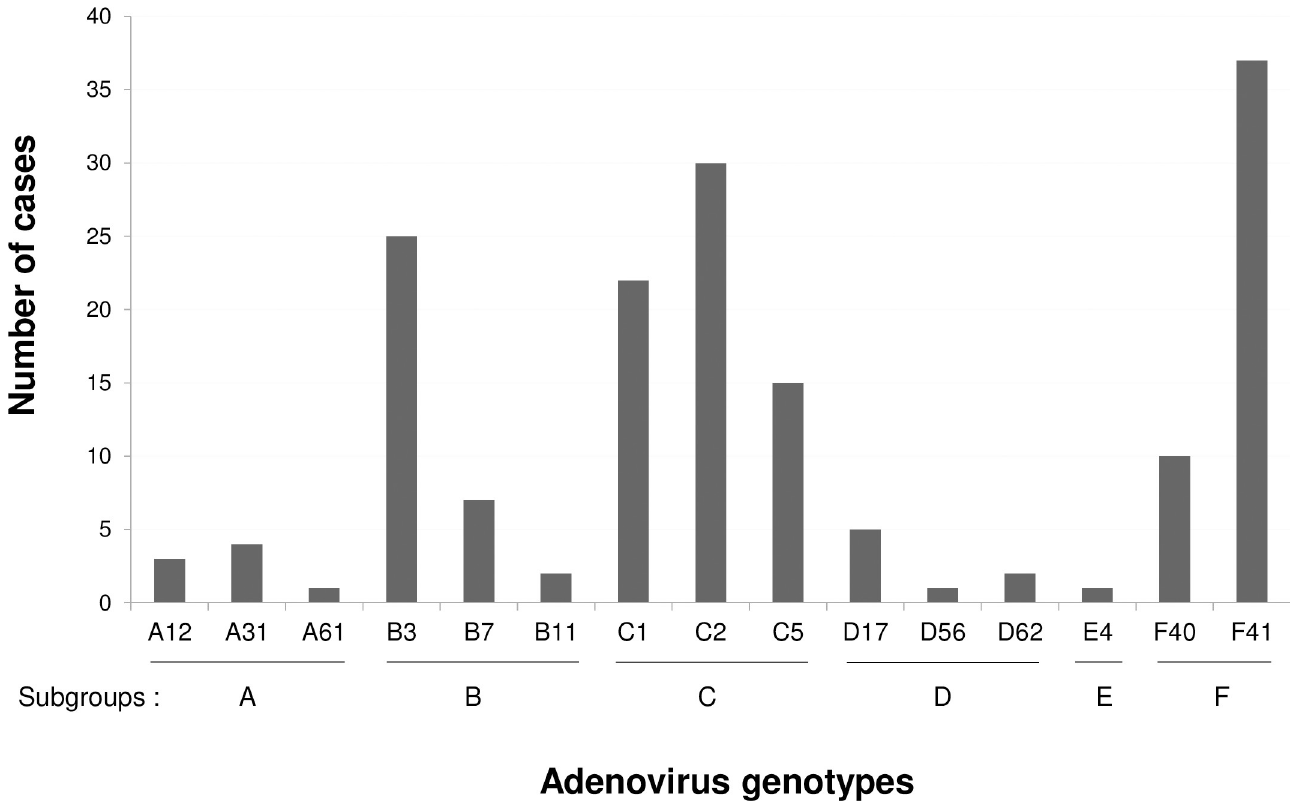
Fig 3. Distribution of human adenovirus genotypes in patients with acute diarrhea in Chiang Mai, Thailand during the study period of seven years from 2011 to 2017.